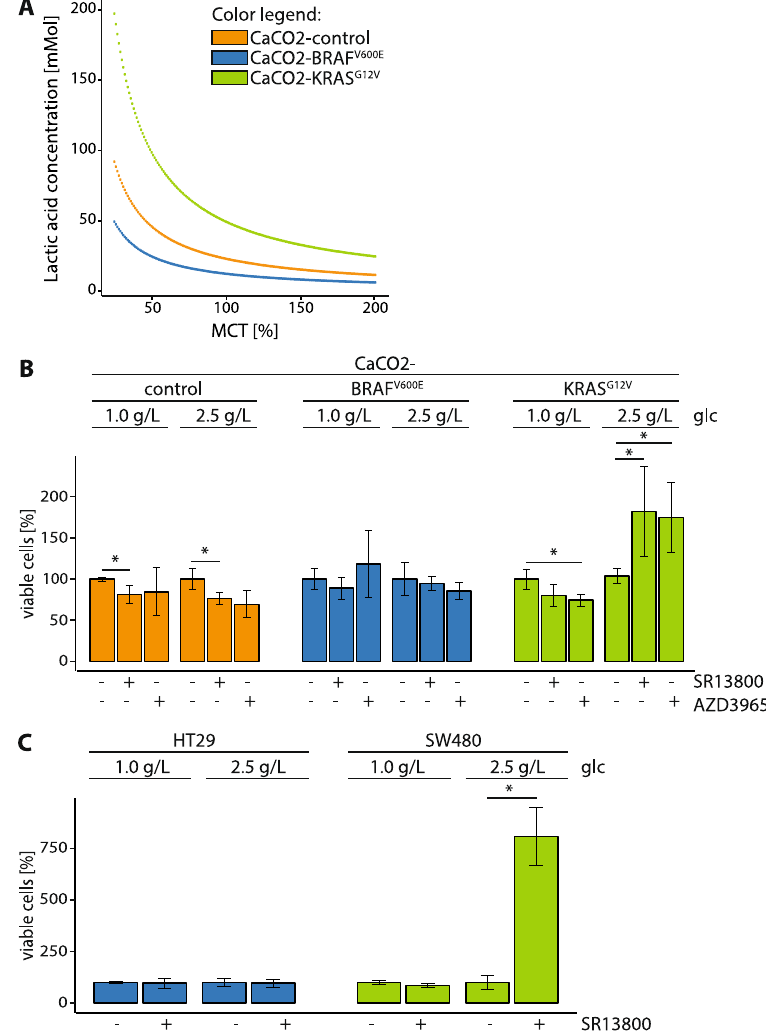
Figure 5. Cells expressing BRAF V600E and KRAS G12V are resistant to MCT1 inhibition. ( A ) Sensitivity analysis of lactic acid concentration depending on the MCT enzyme concentration. The MCT enzyme concentration varies here from 25% to 200% of the fitted value. The model shows how changing the MCT concentration affects the lactic acid accumulation for each cell line model. Low MCT enzyme concentrations result in increasingly large lactic acid concentrations. ( B , C ) CaCO2-control, CaCO2-BRAF V600E , CaCO2-KRAS G12V , HT29 and SW480 cells grown in physiological (1.0 g/L) and intermediate (2.5 g/L) glucose concentrations were treated with 0.1 µ M MCT1 inhibitor SR13800 ( + ), 10 µ M AZD3965 ( + ) or DMSO ( − ) for 24 h. Viable cells compared to DMSO are depicted. Shown are standard deviation of (in minimum) n = 3 replicates. p < 0.05 was indicated with asterisk (unpaired two-tailed t Test). glc: